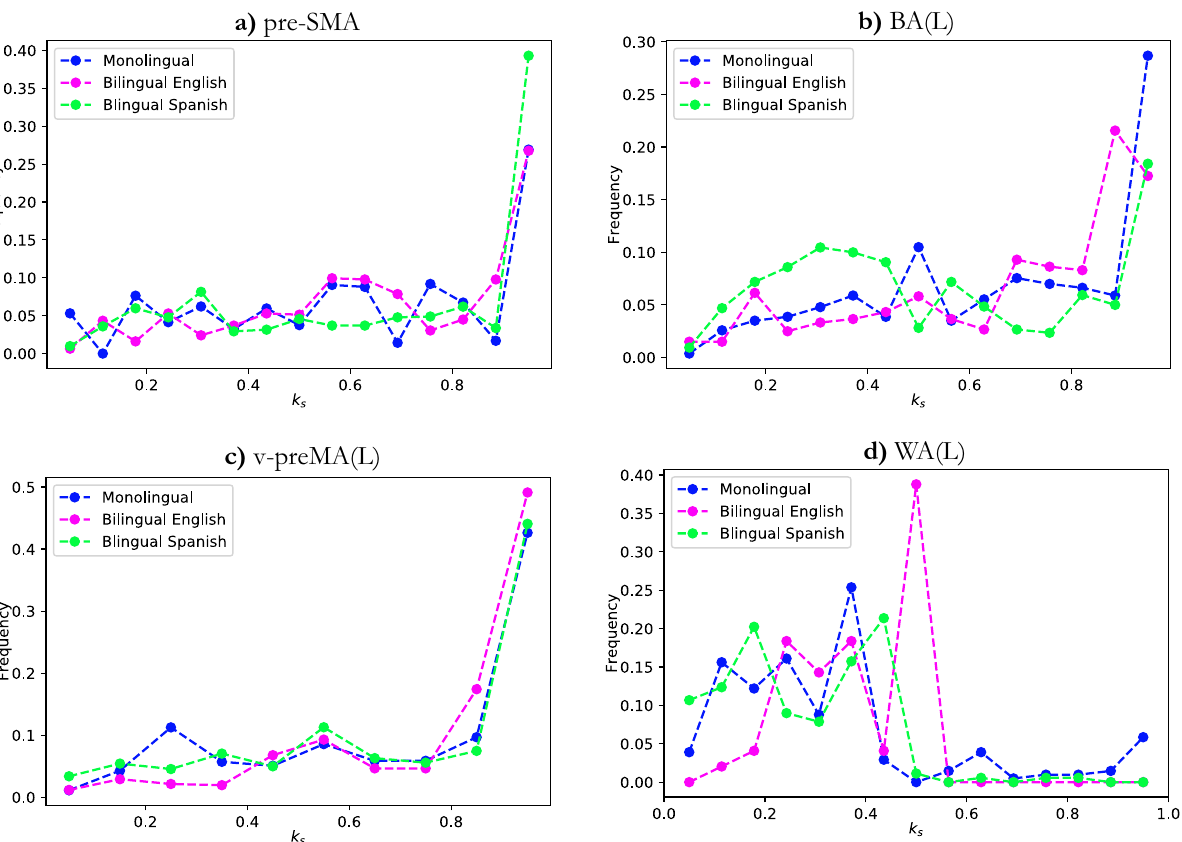
Figure 6. ( a ) Pre-SMA, ( b ) BA(L), ( c ) v-preMA and ( d ) WA k -shell occupancy for all three groups. Different colors represent different groups. Notice that the three colored curves are most distinctive in ( d ). For this